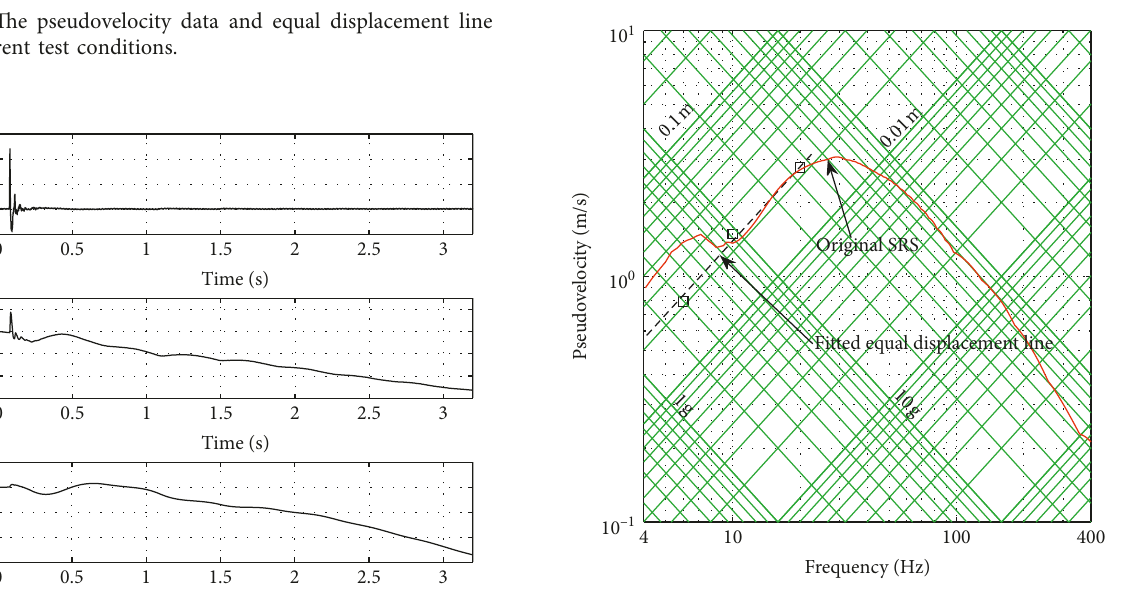
Figure 7: The original SRS and the fitted equal displacement